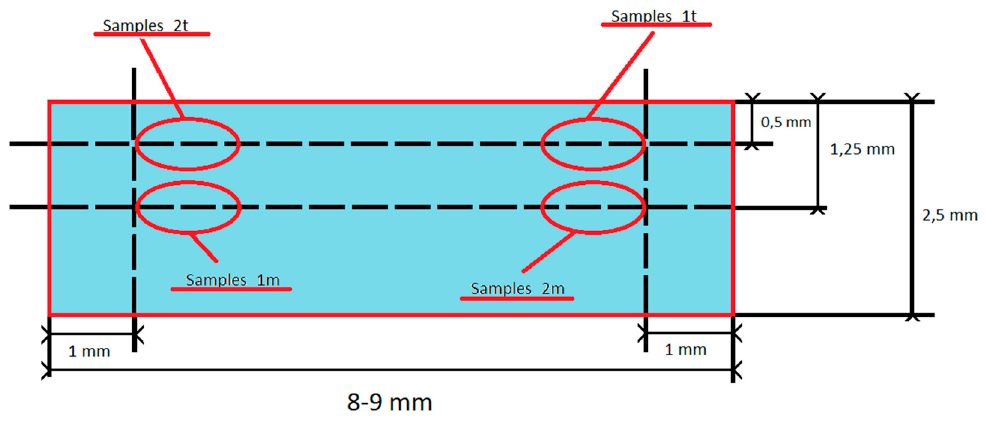
Figure 5. Schematic of regions within the specimens analyzed for porosity and grain size (t = near top, m = middle).